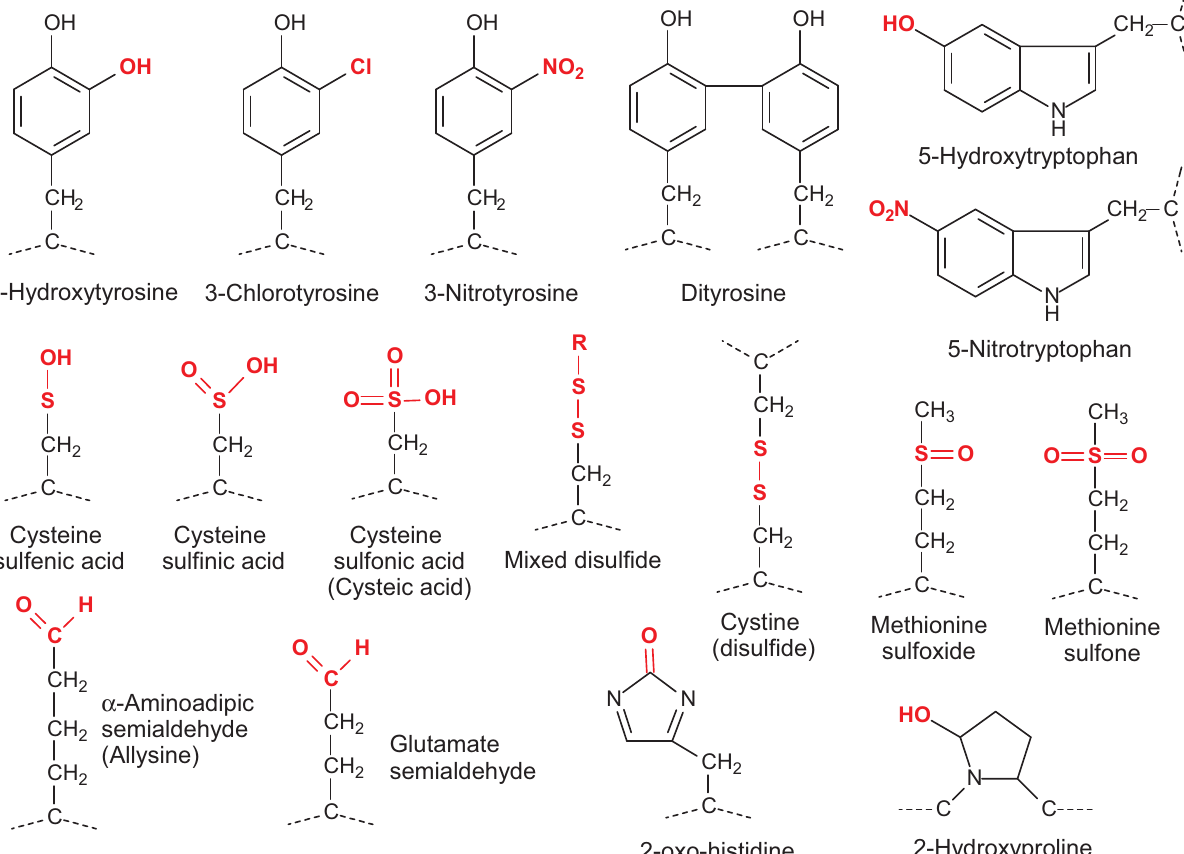
Figure 1. Structures of oxidized residues most commonly detected and studied by mass spectrometry. In mixed disulfides, R can be cysteine or glutathione